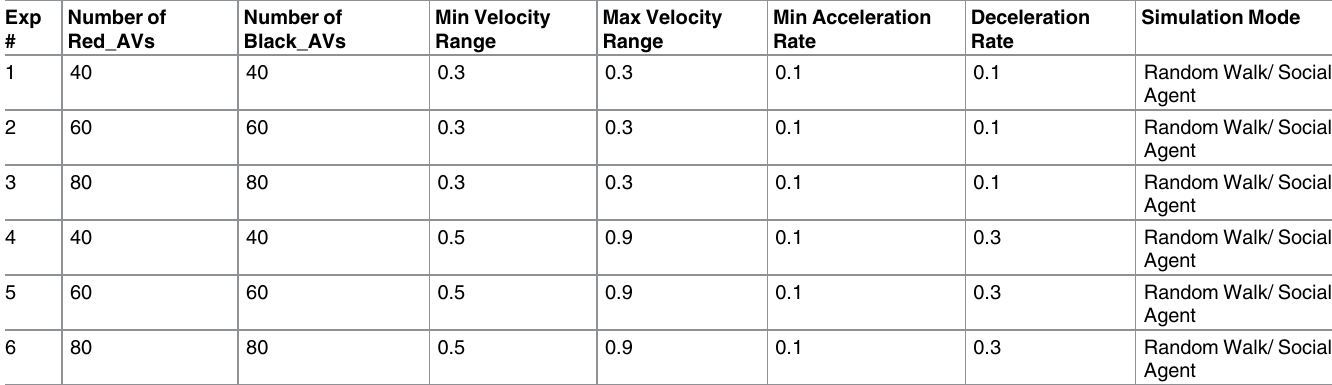
Table 2. Test cases along the parameters and their corresponding values.